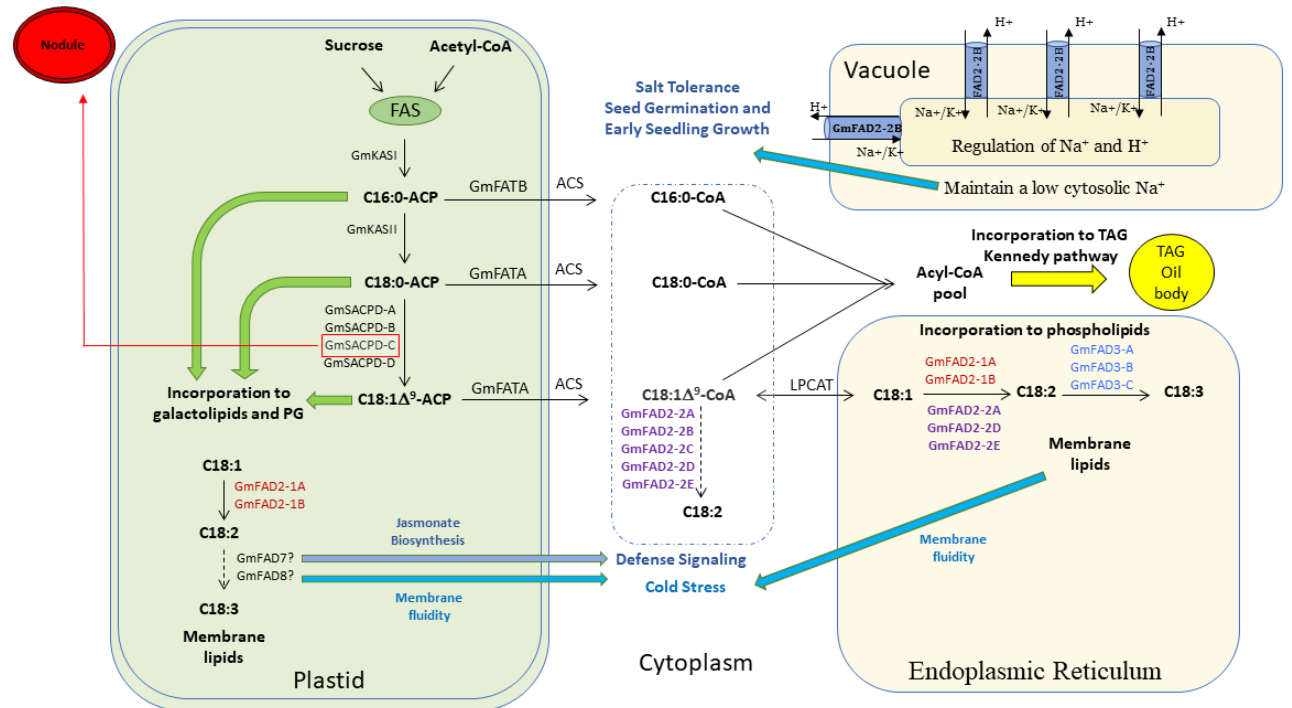
Figure 6. Cartoon deciphering the soybean seed fatty acid biosynthesis pathway. The seven GmFAD2-1 and GmFAD2-2 members are responsible for converting oleic acid (C18:0-ACP) to linoleic acid (C18:1 Δ 9 -ACP) in the plastid (GmFAD2-1A and GmFAD2-1B), ER (GmFAD2-1A, GmFAD2-1B, GmFAD2-2A, GmFAD2-2D, and GmFAD2-2E), and cytoplasm (GmFAD2-2A, GmFAD2-2B, GmFAD2-2C, GmFAD2-2D, and GmFAD2-2E). GmFAD2-2B is located in the vacuole and is likely to play a role during seed germination and early seed growth by maintaining low cytosolic Na + as described in Arabidopsis [65]. In bold are the five newly identified fatty acid desaturases involved in the unsaturated fatty acid biosynthesis. GmFAD2-2A, GmFAD2-2B, GmFAD2-2C, GmFAD2-2D, and GmFAD2-2E members present a good